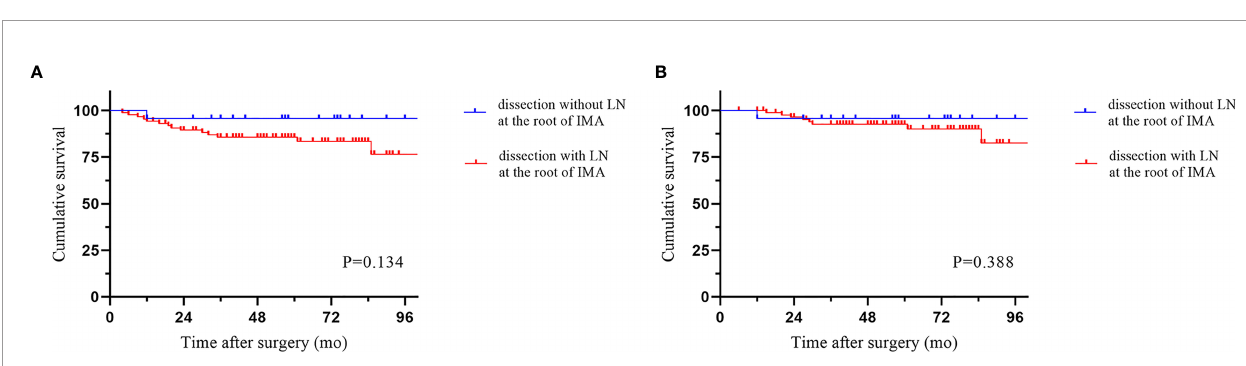
FIGURE 3 | Survival according to whether lymph nodes at the root of the IMA were dissected. (A) Disease-free survival. (B) Overall survival.